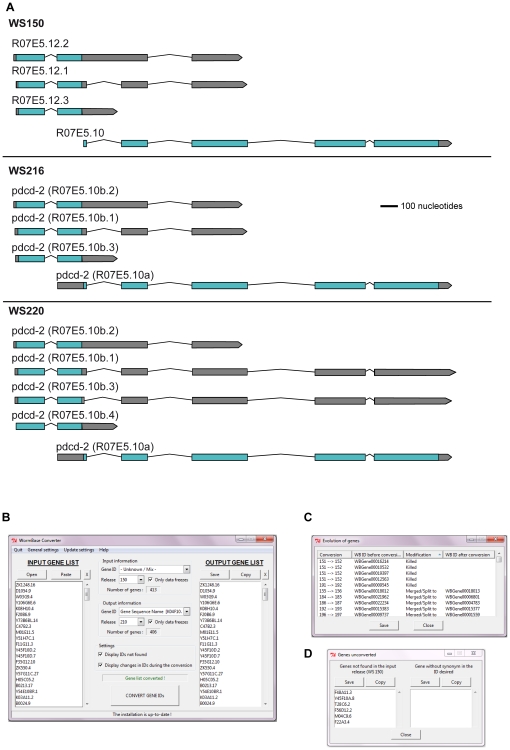
The WormBase Converter.Constant changes in gene annotations create the need for WormBase Converter. (A) Example of the gene R07E5.12 that has undergone a merge with R07E5.10, which then has been re-annotated. More recently, as seen here in WS220, the structure of R07E5.10 has been further modified. (B) Example of an input list with CDS Sequence names as identifiers based on WormBase version WS150 and the corresponding output list in WS210 using gene sequence name as identifier. The output list can be copied and pasted into any spreadsheet for further use. The number of successfully converted genes is indicated. In this case, 11 out of 413 genes were absent from the output list; 5 had been “killed”, and 6 not found in the WS150 release. On the other hand, because of gene splits, the output list contained 4 new genes. (C) List showing the changes that occurred during the conversions, the nature of the change and the version when the change was implemented, including the 5 “killed” genes. (D) List of 6 genes that were not found in the version used as input.